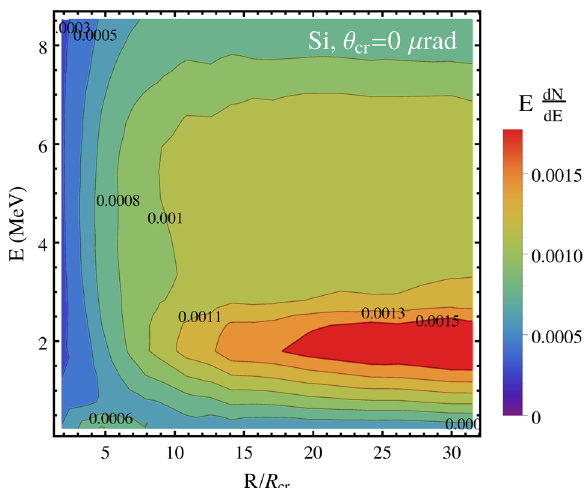
FIG. 5. Simulated radiation spectra of 855 MeV electrons in a Si bent crystal 15 μ m thick in dependence on the ratio of the crystal radius and its critical value. The beam angular divergence is 21 . 4 μ rad, the angle of crystal alignment is